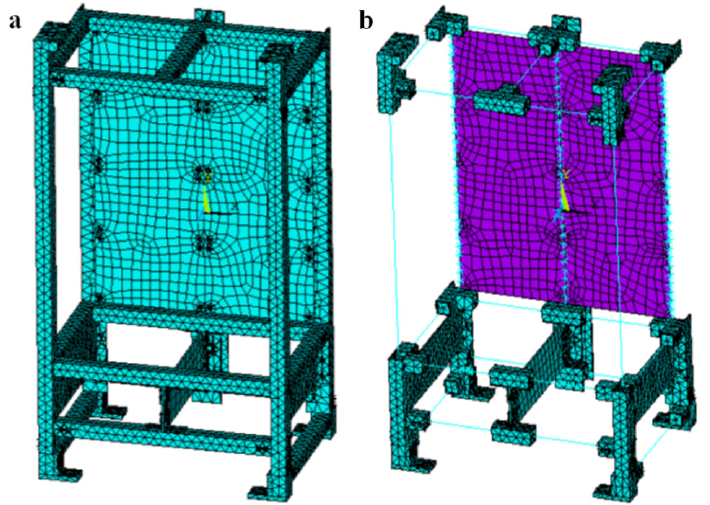
Figure 2. Two FE models of the experiment rack simulator. ( a ) Solid FE model. ( b ) Mixed FE model. Table 1. Specific settings of two FE models of the experimental rack simulator.